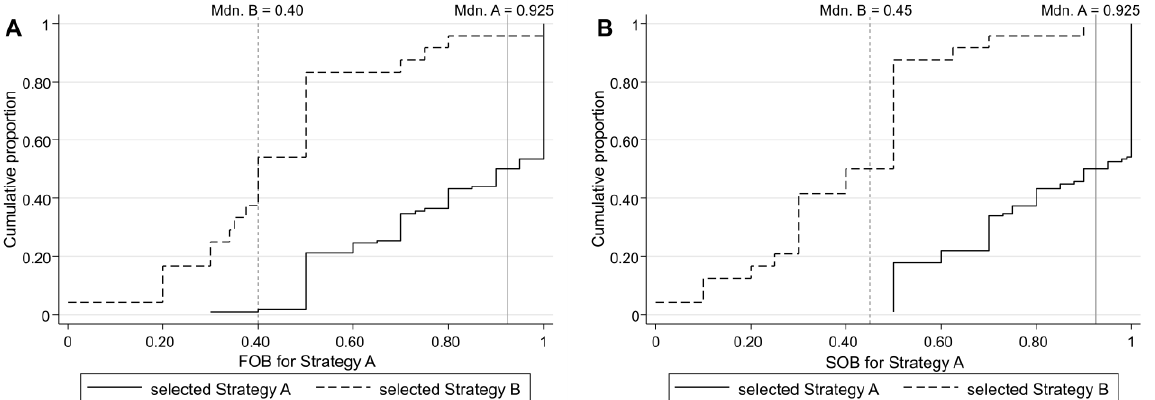
Figure 2. CDFs of ( A ) probabilistic FOB and ( B ) probabilistic SOB of participants who selected Strategy A and of those who selected Strategy B. Mdn. A = Median ( A ) FOB and ( B ) SOB of those who selected Strategy A; Mdn. B = Median ( A ) FOB and ( B ) SOB of those who selected Strategy B.